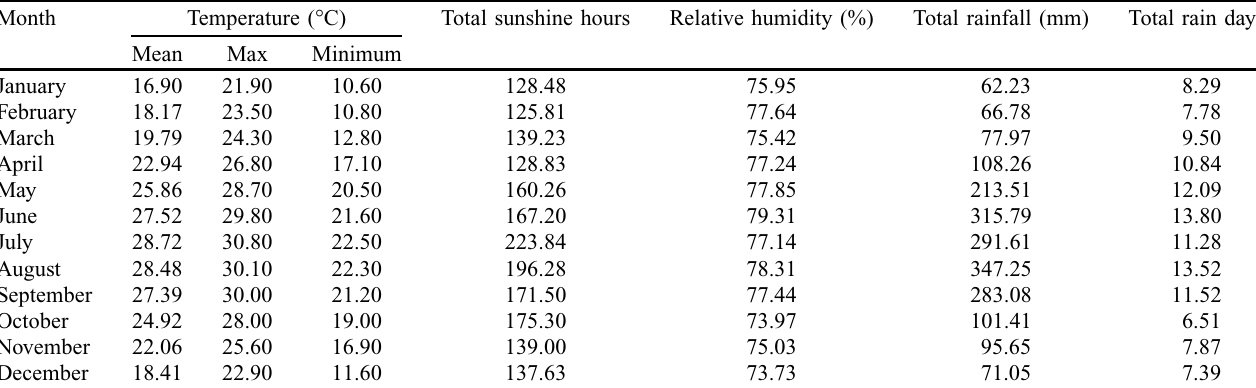
Table 2. Average monthly mean meteorological factors in Taiwan from 2000 to 2013.